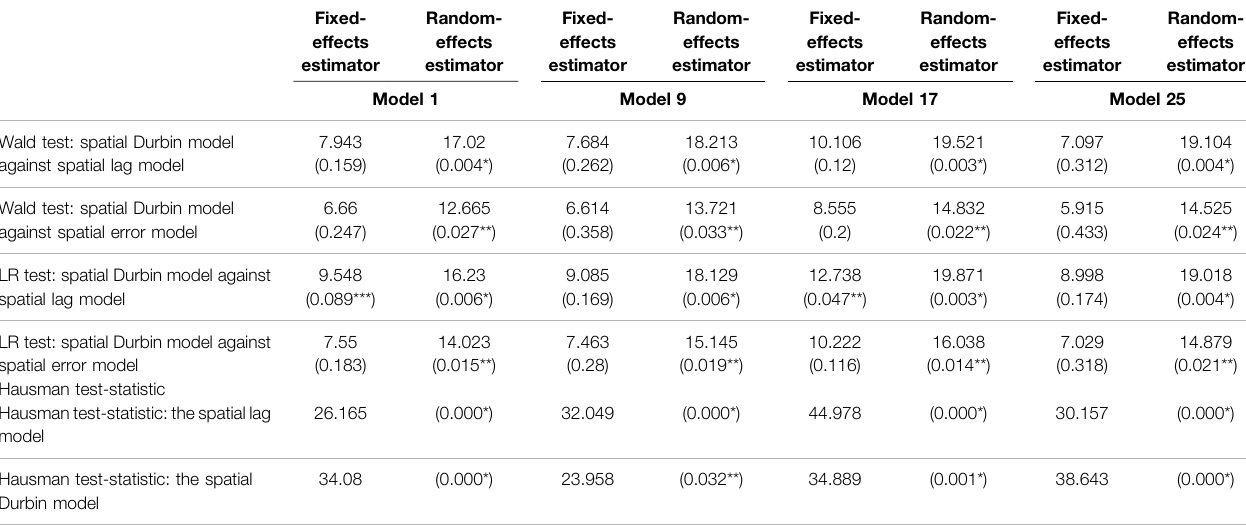
TABLE 5 | Spatial Durbin model and Hausman